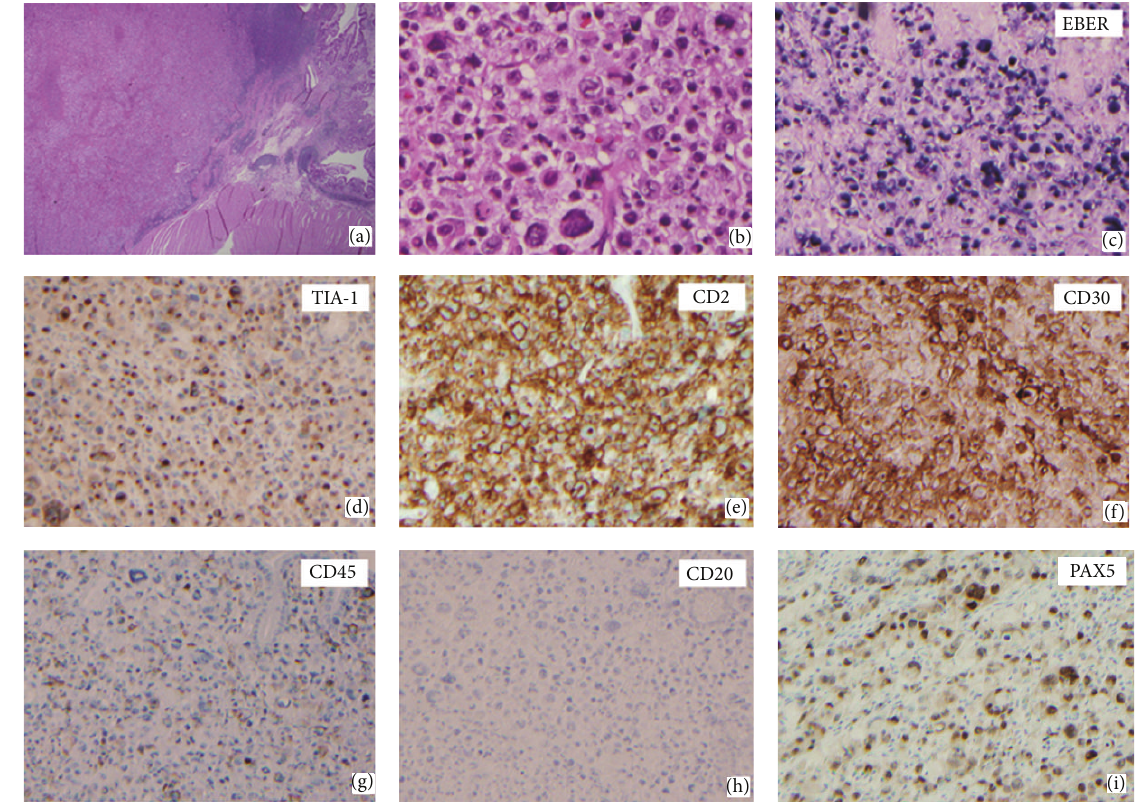
Figure 1: Histopathologic features and immunophenotype of anaplastic appearing area of the lymphoma. (a) The transmural tumor mass in the duodenum with spared small bowel at right (H&E, 20x). (b) Sheets of neoplastic lymphoid infiltrate with anaplastic morphology with horseshoe and ring-shaped multinucleated cells intermixed with other large atypical cells (H&E, 200x). Positive staining for EBER by in situ hybridization (c), TIA-1 (d), CD2 (e), CD30 (f), and variable staining for CD45 wherein most large cells are negative (g). CD20 is absent (h), while PAX5 is present in a nuclear location, as expected